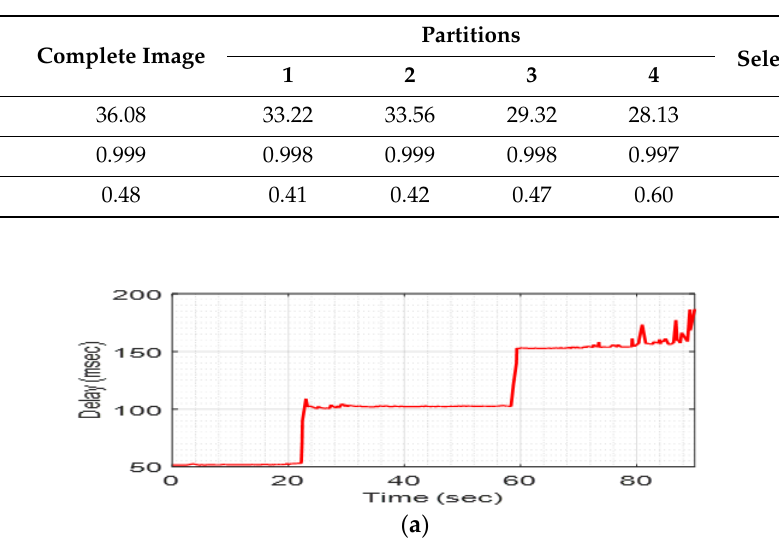
Table 4. Peak signal-to-noise (PSNR), structural similarity index measurement (SSIM) and image di ff erence (ID) for full and partitioned images (these were obtained from the image shown in Figure 8a and its partitions in Figure 9).